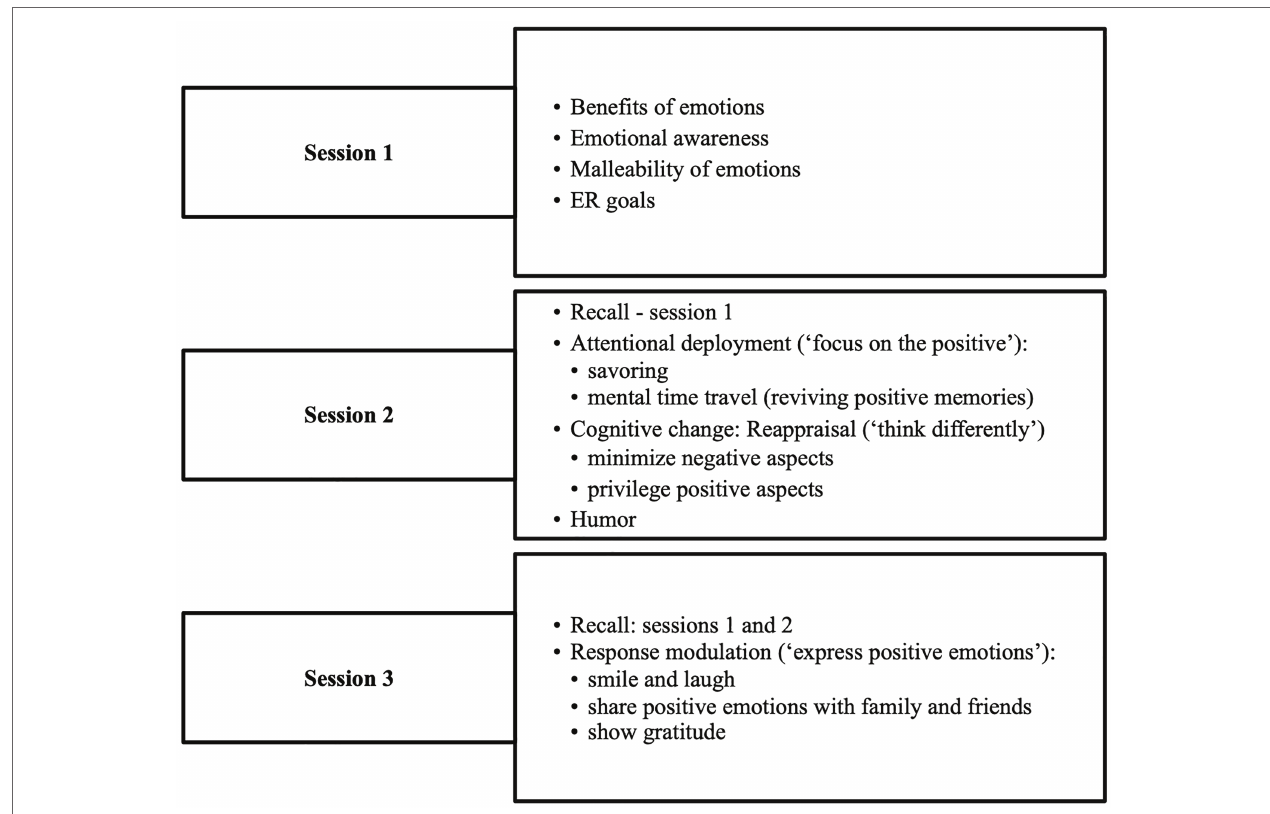
FIGURE 2 | Session content of the positive emotion regulation training